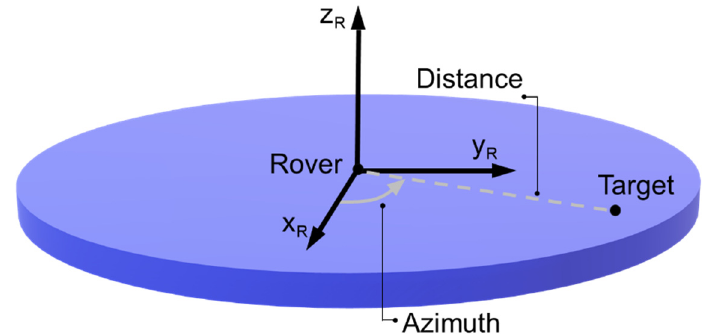
Figure 3. The main parameters of the control strategy.